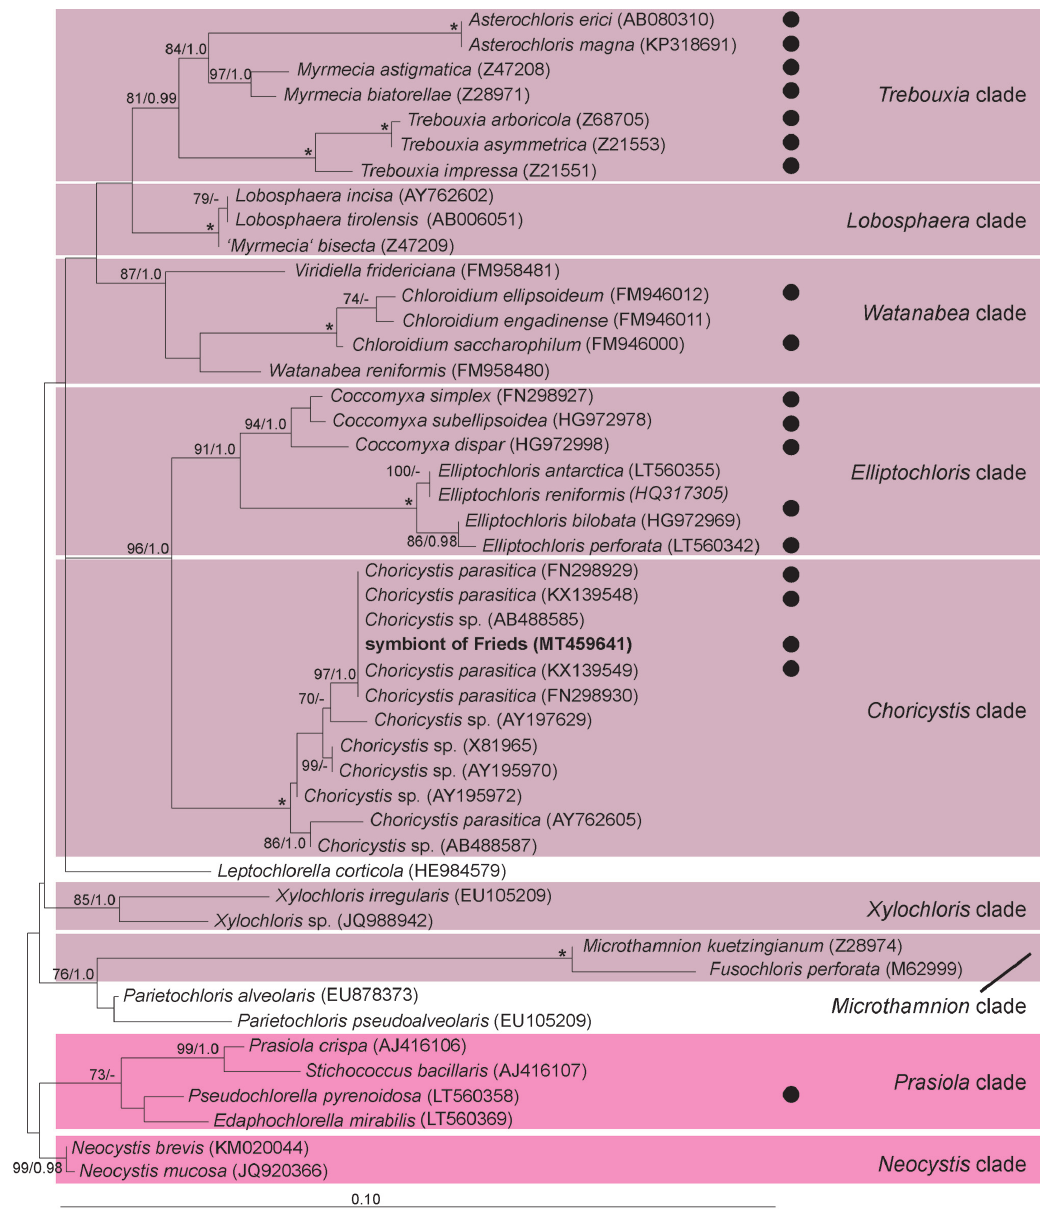
Figure 6. Molecular phylogeny of Choricystis parasitica and closely related members of the Chlorellaceae based on partial SSU gene sequences. Maximum likelihood tree based on 948 aligned positions. GTR + I + G was used as evolutionary model. Bootstrap values above 70 % and Bayesian Inference values above 0.95 are indicated. Asterisks indicate maximum support in both analyses. Dark circles indicate species capable of living in symbiosis, in case of Choricystis the symbiotic strains are highlighted. Species belonging to the Prasiola and Neocystis clades were chosen as outgroup. The obtained sequence is marked in